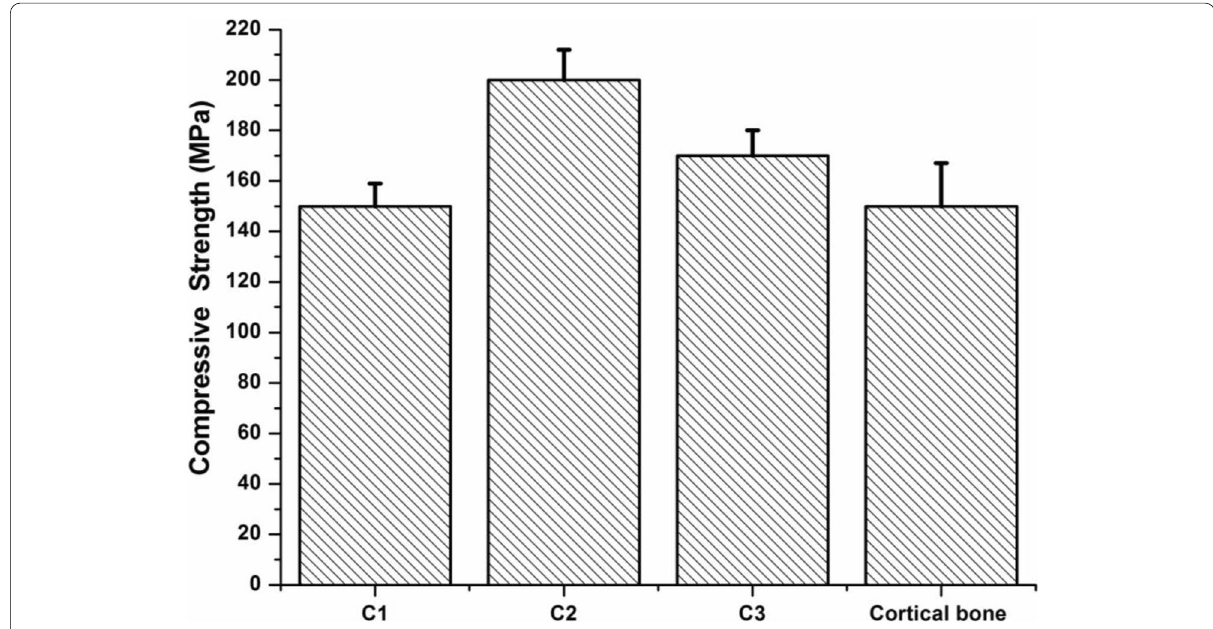
Fig. 6 Compressive strength of the prepared ceramic nanocomposites with reference to cortical bone